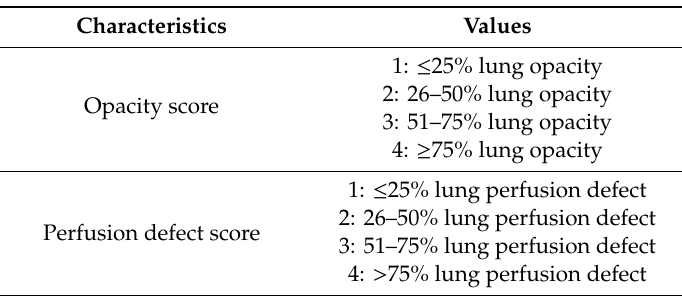
Table 1. Evaluation